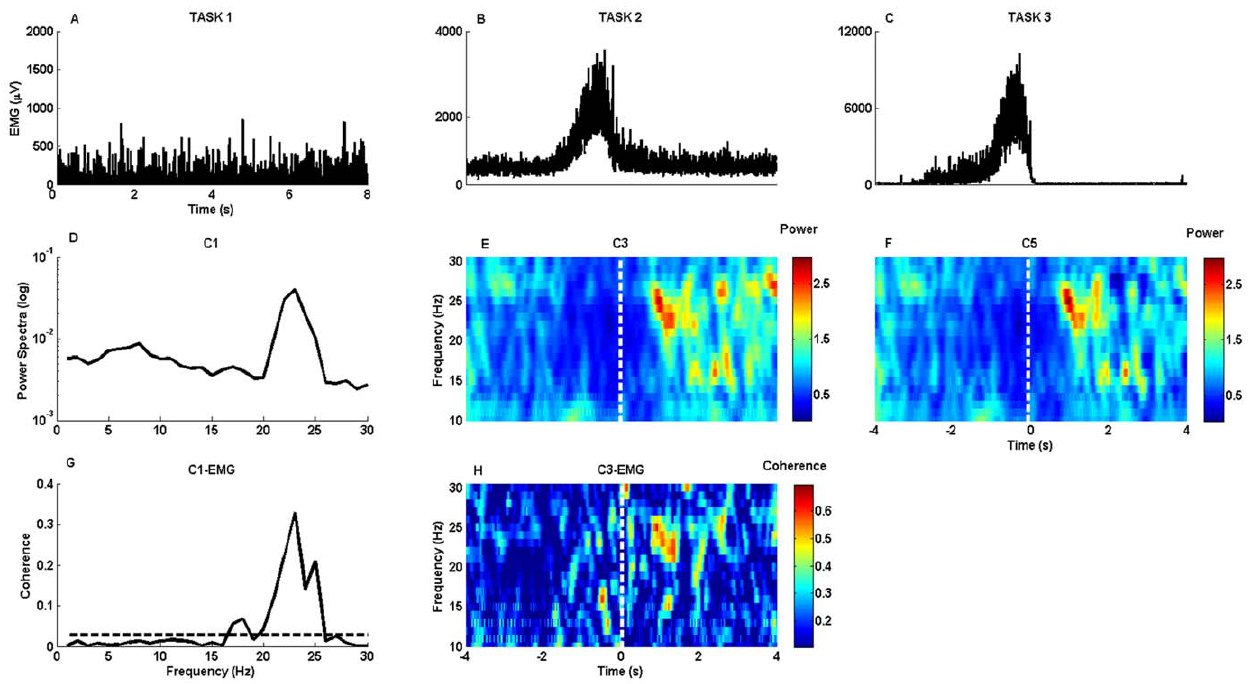
Figure 1. Time-frequency analysis of EEG power and cortico-muscular coherence of one representative subject. The plots A, B and C represent the raw EMG data from the three tasks. The corresponding EEG power spectrums of each task are shown in plots D, E and F. The dashed white line indicates the movement termination in Task2 and Task3. The G shows the coherence between the C1 electrode and EMG in Task1; F plot represent the coherence between the C3 electrode and EMG in Task2. Note the same frequency range for beta power increase and cortico-muscular coherence in the tasks.